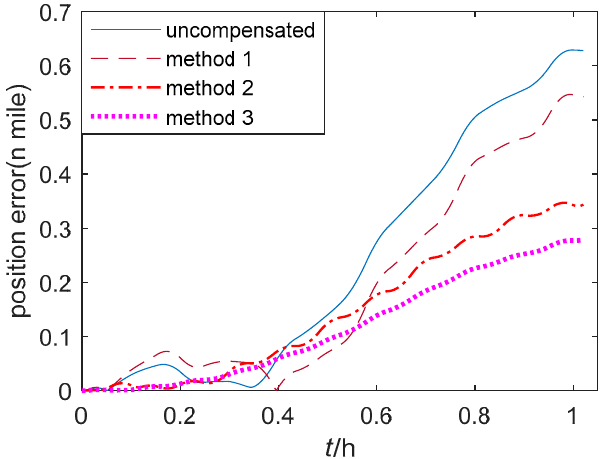
14 of 19 Figure 10. The single-axis RINS installed on the three-axis turntable. Table 9. The quasi-static and swing condition of the turntable. Turntable Condition